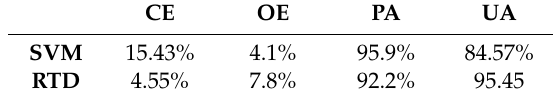
Table 9. The cloud CE, OE, PA, and UA for the SVM and RTD methods for the Xinjiang area.